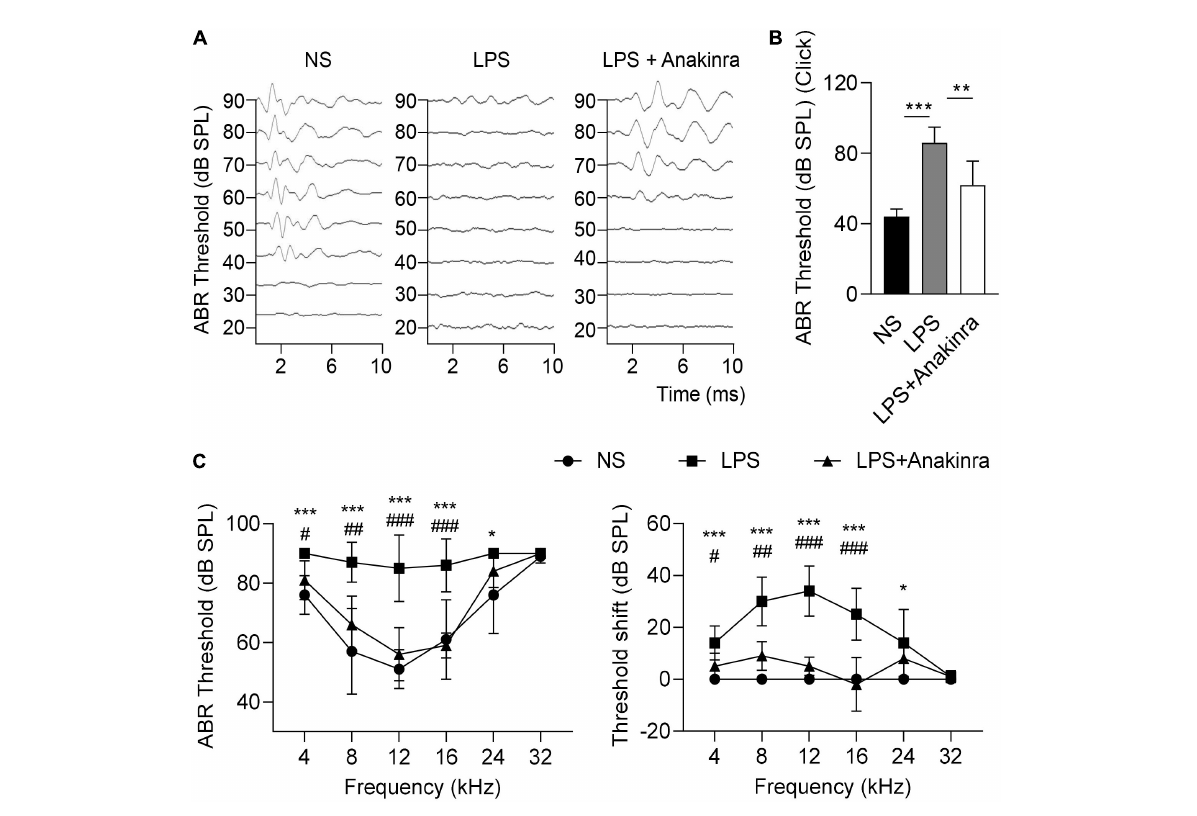
FIGURE4 Anakinra ameliorated LPS-induced hearing loss in mice. (A) Representative serial ABR wave recordings in response to click sounds ( n = 5). (B) ABR thresholds in response to click sounds ( n = 5). (C) ABR thresholds and threshold shift in response to pure tone bursts across all frequencies tested (4, 8, 12, 16, 24, and 32 kHz) ( n = 5). Data are presented as mean ± SD. *or # p < 0.05, **or ## < 0.01 ***or ### p < 0.001. NS, 0.9% normal saline; ABR, auditory brainstem